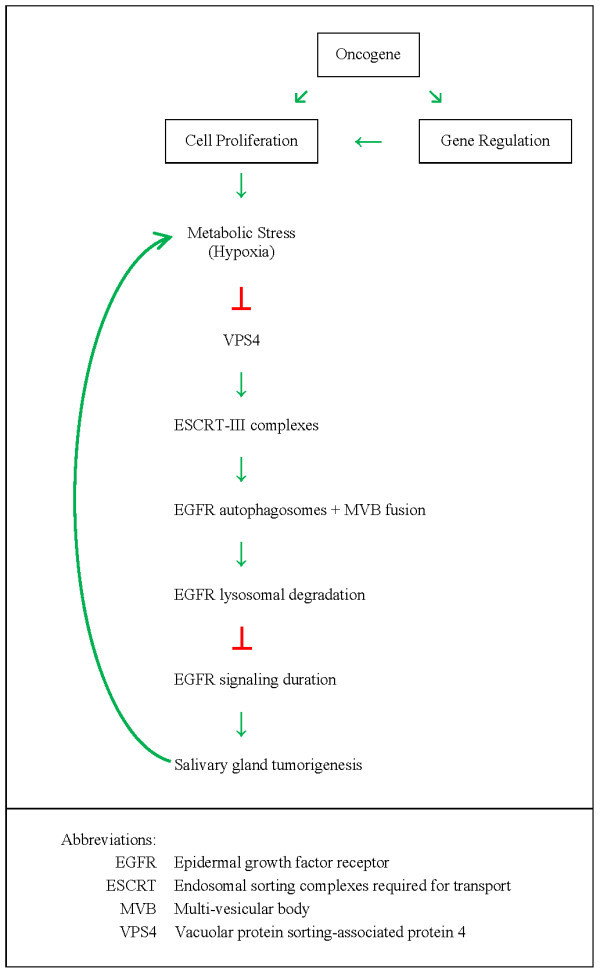
Diagram of tumorigenesis mechanism. Loss of VPS4 function promotes salivary gland tumorigenesis through its effect of prolonging the duration of EGFR signaling.